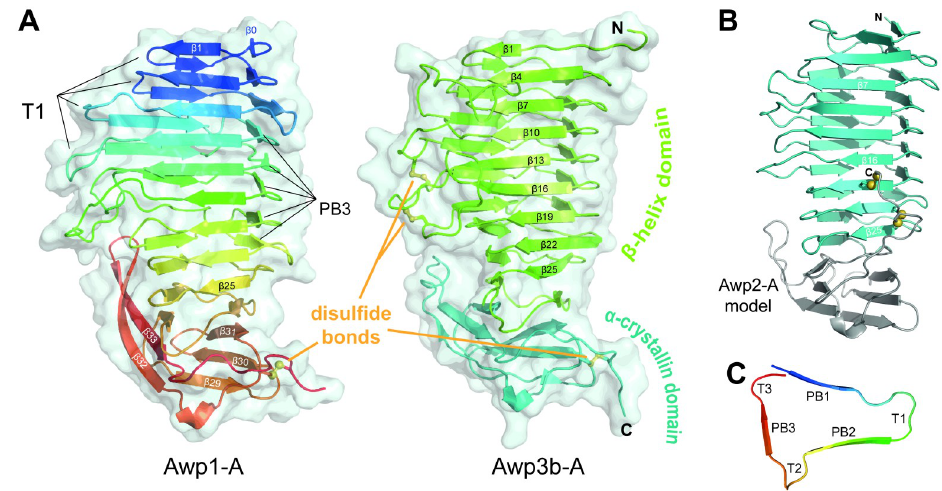
Fig 4. Structures of the Awp1, Awp2 and Awp3b A-regions. (A) Left, crystal structure of the Awp1 A-region. The nine β -helix turns are colored according to S1 Fig. The C-terminal α -crystallin domain is depicted in orange. Right, crystal structure of the Awp3b A-region. (B) Model of the Awp2 A-region based on transformer-restrained modelling by trRosetta. (C) Architecture and nomenclature of β -helix turns.